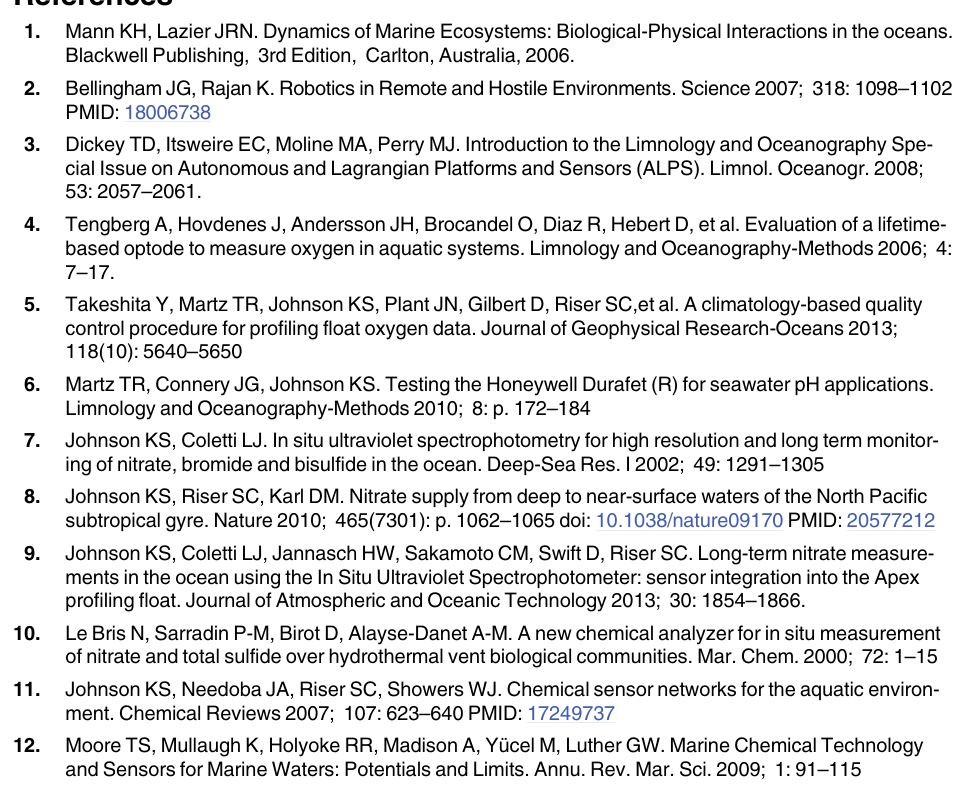
S2 Fig. Cross correlation matrices for the multi-parameter datasets obtained from 50 and 100m. Units are μ M for NO 2- , NO 3- and O indicate significant correlation (p < 0.01) between the pair. (TIFF) S1 File. All data from the LOC sensors and autoanalyzer measurements on bottle samples. (ZIP) S2 File. All data from the POZ landers on the current measurements in the bottom waters.